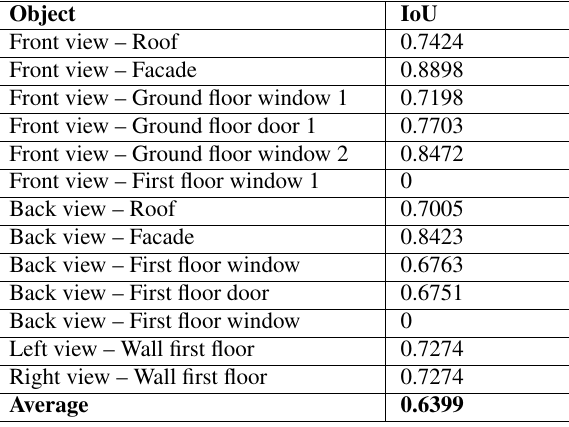
Table 5. IoU results for BAG ID